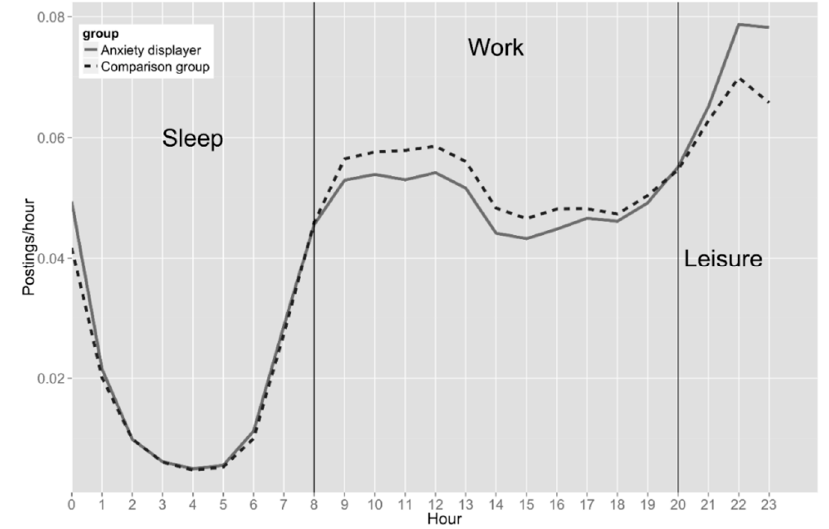
Figure 3. Diurnal trends (average number of postings posted hourly through a day).